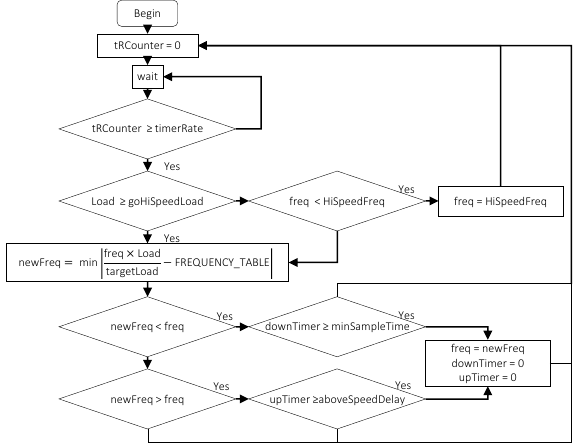
Figure 5. A simplified flowchart for modeling of the Interactive